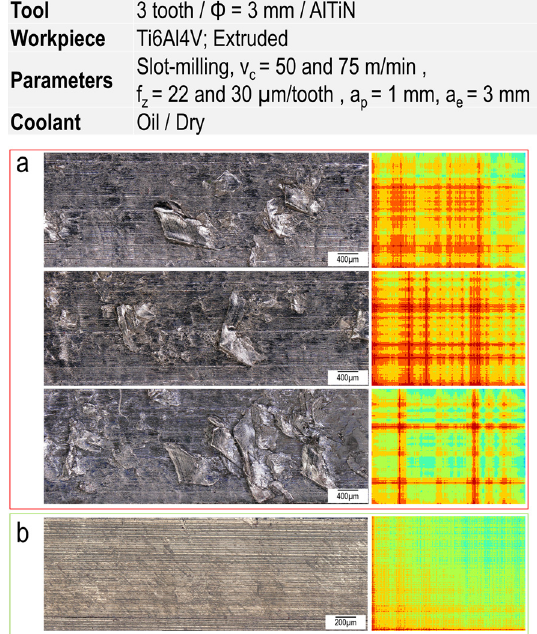
Figure 10. Exemplary milled surfaces and their corresponding GASF images; ( a ) at v c = 75 m/min and f z = 22 µm/tooth in dry machining and ( b ) at v c = 50 m/min and f z = 30 µm/tooth with oil.